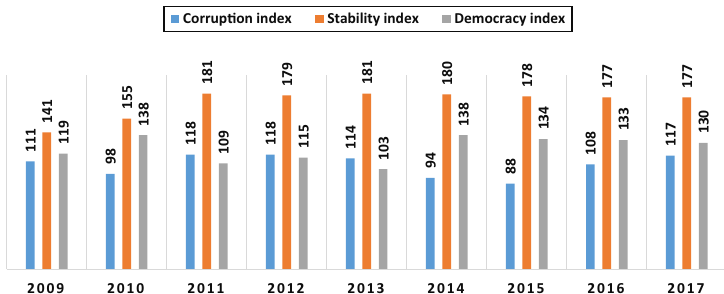
Figure 6. Democracy, political stability and corruption